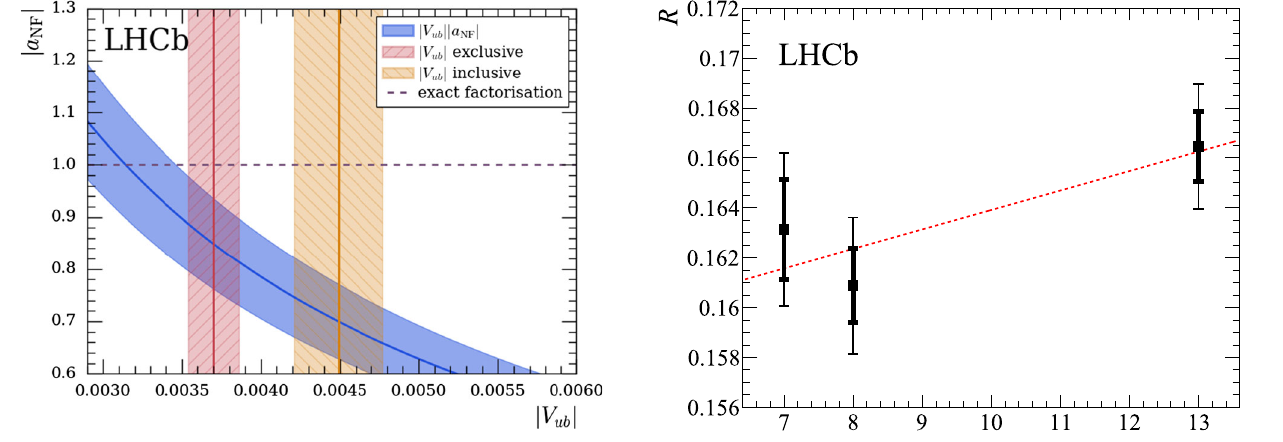
Fig. 4 Result of the determination of | V ub || a NF | . The blue line rep- resents the result of this measurement, the vertical bands are the known exclusive and inclusive measurements of | V ub | , which are ( 3 . 70 ± 0 . 16 ) × 10 − 3 and ( 4 . 49 ± 0 . 28 ) × 10 − 3 , respectively [38]. The horizontal dashed line at | a NF | = 1 . 0 represents exact factorisa- tion. The error bands represent an uncertainty of one standard deviation